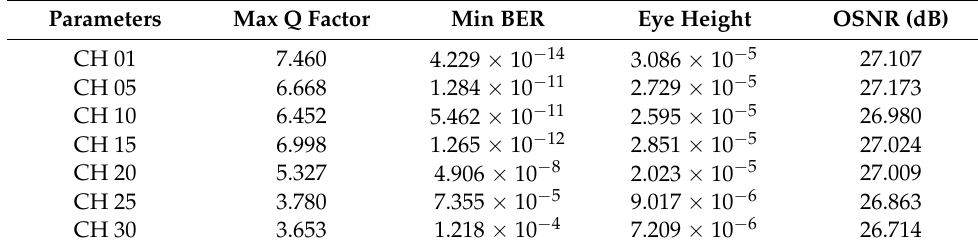
Table 9. Results of 32-channel EDFA DWDM